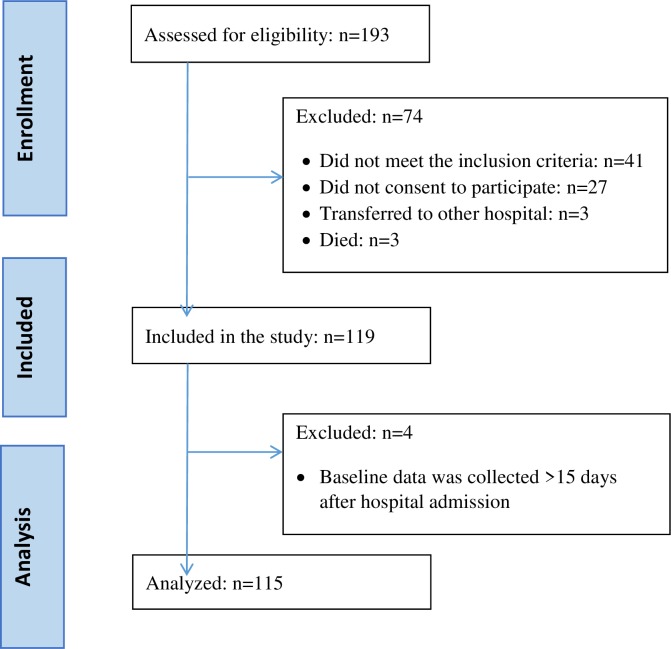
Flow chart showing the recruitment and inclusion of patients in the study.